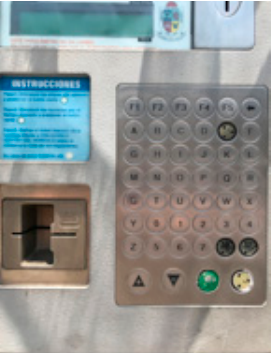
Figure 29. Interface of CFE-Matic ATM used for paying electricity bills. Confused elderly person not know how to pay bill. does not know how to pay bill.